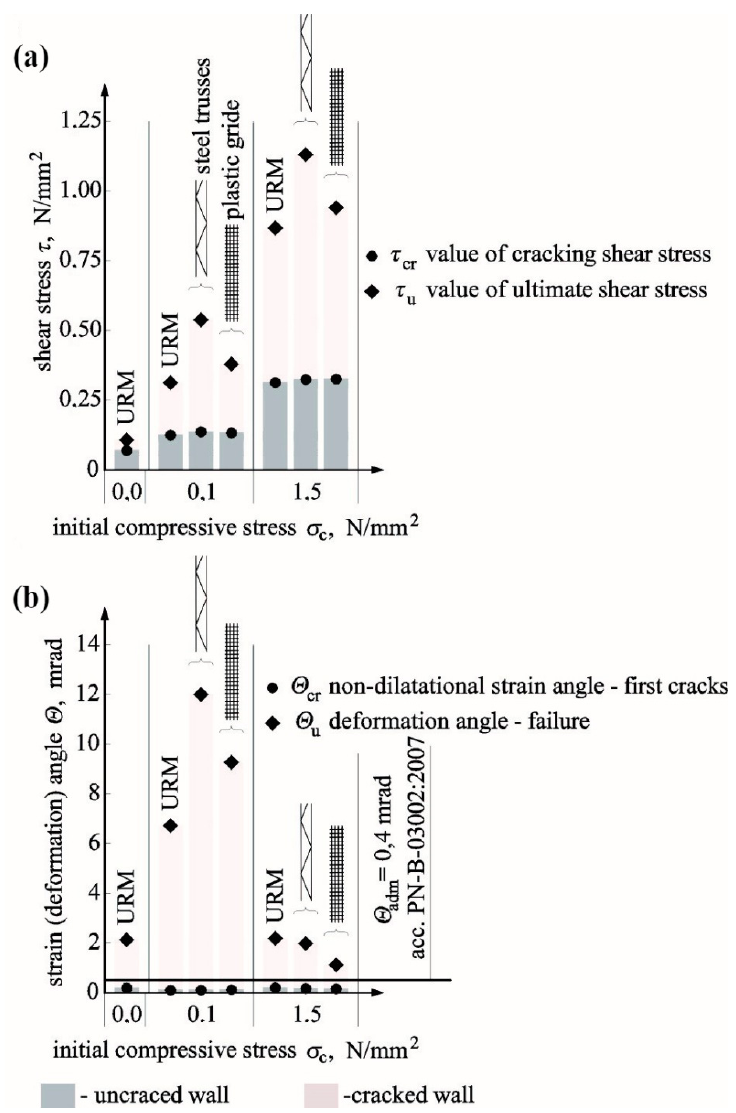
Figure 13. Comparison of test results: ( a ) shear stress at the time of cracking and failure and ( b ) shear–strain angle at the time of cracking and shear deformation angle at the time of failure.